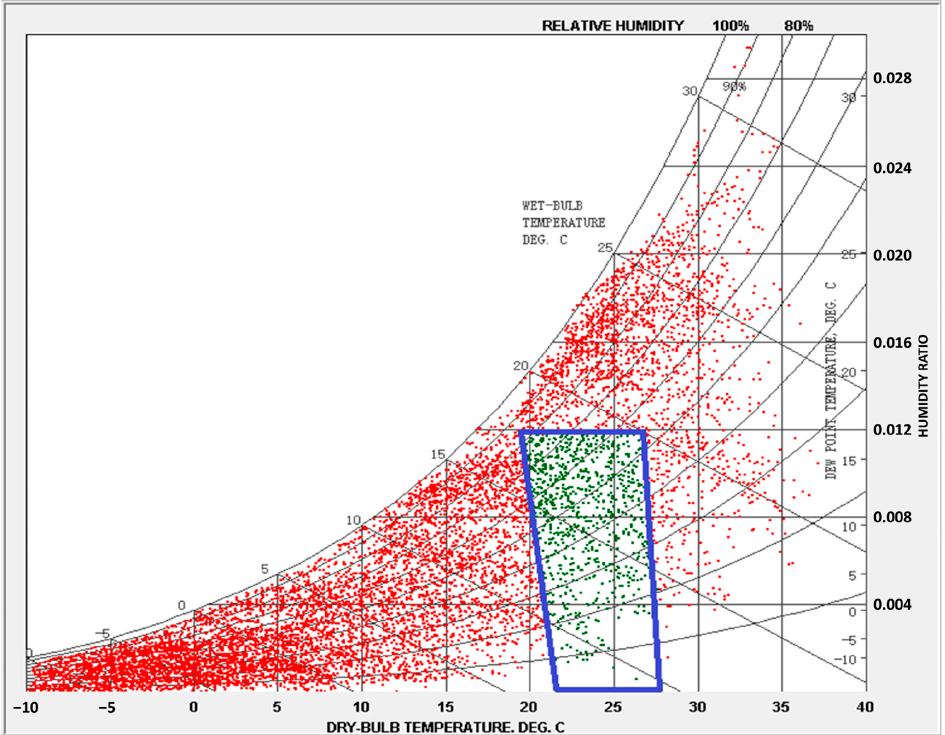
Figure 2. Dry − bulb temperature and moisture content of ambient air in Beijing weather data set (red dots) and the thermal comfort zone (green dots) specified in the ANSI/ASHRAE standard 55.